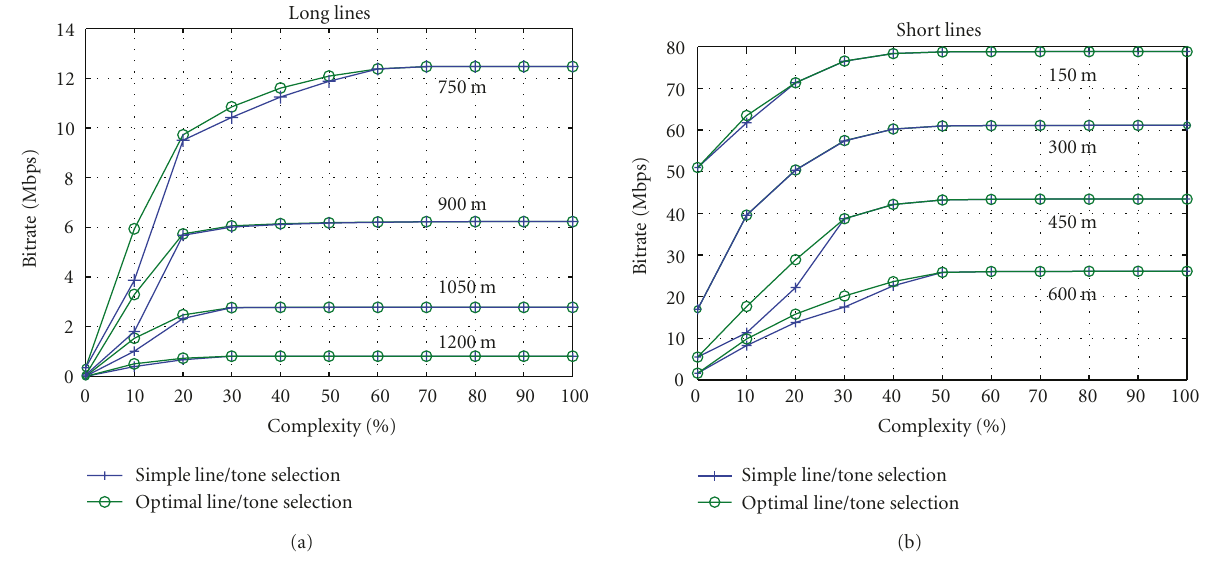
Figure 3: Performance comparison between optimal and simple line/tone selection